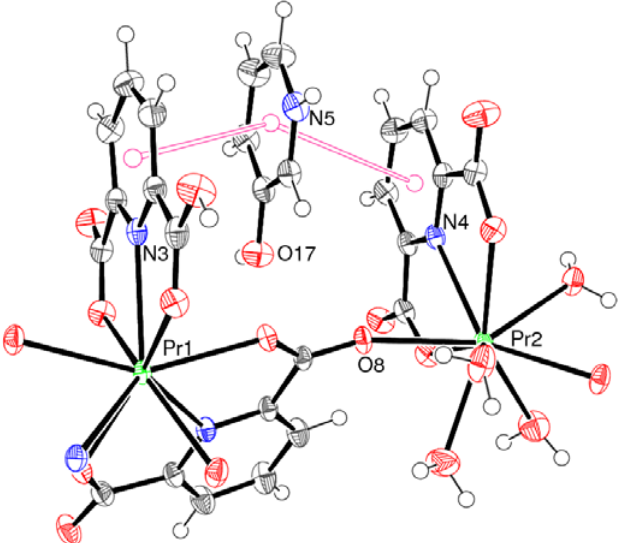
Figure 5. Fragment of the structure of 1 showing the π – π stacking interactions (open pink lines) of the “intercalated” H3hp + cation: The separations of its ring centroid with those of the N3- and N4-containing rings (indicated by pink spheres) are 3.596(2) Å and 3.647(3) Å,